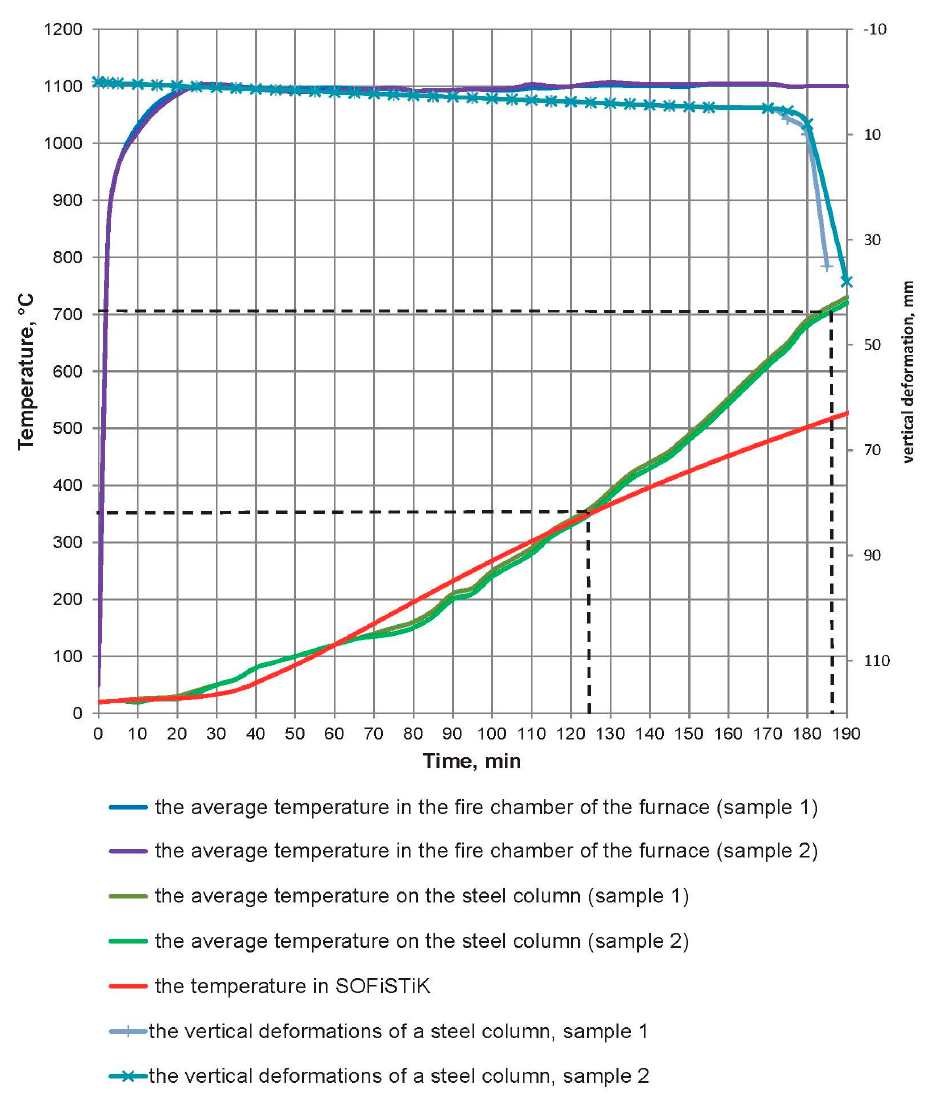
Figure 11. Temperature curves for the furnace firebox, for the experimental prototypes heating, and SOFiSTiK simulation values for hydrocarbon fire.